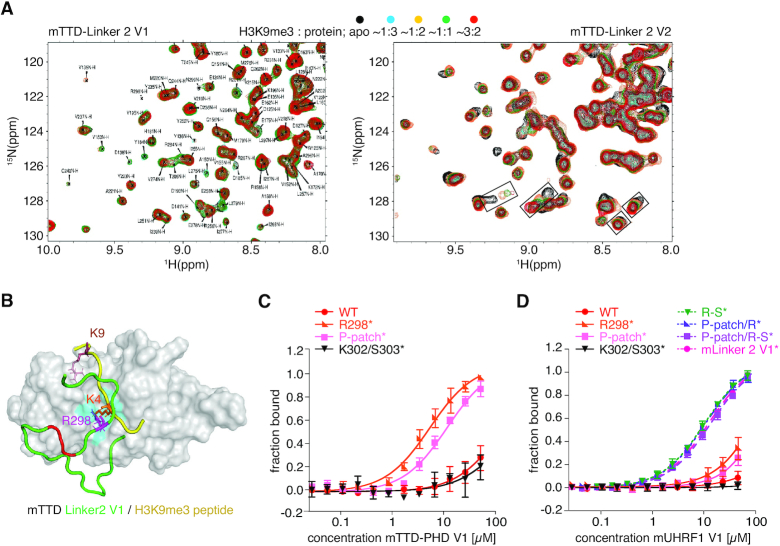
mLinker 2 V1 blocks the surface groove and R-pocket of mTTD. (A) (1H–15N) HSQC titrations of mTTD-Linker 2 V1 (left) and V2 (right) acquired in the presence of unlabeled H3(1–15)K9me3 peptide at different molar ratios. (B) NMR-derived structure of mTTD-Linker 2 V1 with surface representation of mTTD in grey and mLinker 2 V1 in green. The P-patch (i.e. P293, P294 and P295) of mLinker 2 V1 is colored in red. The R-pocket (cyan) is occupied by R298 (magenta – stick representation). The model shows the putative positioning of the H3K9me3-tail (yellow) on the surface of the mTTD, as derived from the analysis of the hTTD/H3K9me3 complex ((6); PDBID: 2L3R). The K9me3 residue of the H3-tail would occupy the aromatic cage, and H3K4 the R-pocket. However, because R298 of mLinker 2 V1 (green) is stably bound to the R-pocket and the surface groove is occupied, H3K9me3-binding by the isolated mTTD is blocked in mUHRF1 V1. (C) Titration series of recombinant mTTD-PHD V1 WT and R298A (R298*), P293A/P294A/P295A (P-patch*), and K302A/S303A (K302/S303*) mutant proteins with a FAM-H3(1–15)K9me3 peptide were analysed by fluorescence polarization. Data are plotted as average of three independent experiments; error bars correspond to s.d. (D) Fluorescence polarization binding experiments as in (C) but using recombinant mUHRF1 V1 WT, R298*, P-patch*, K302/S303* or P293A/P294A/P295A/L297A/R298A (P-patch/R*), R298A/N299A/T300A/G301A/K302A/S303A (R-S*), P293A/P294A/P295A/R298A/N299A/T300A/G301A/K302A/S303A (P-patch/R-S*) and P293A/P294A/P295A/L297A/ R298A/N299A/T300A/G301A/K302A/S303A (mLinker 2 V1*) proteins.